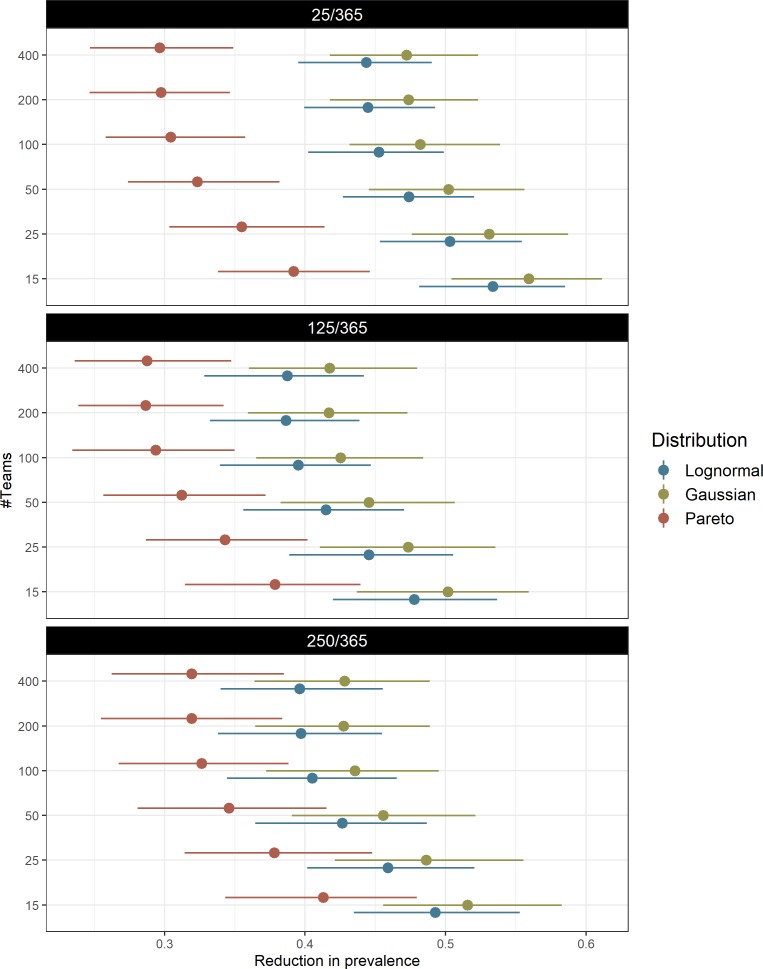
Interplay between logistics and human population topologies.Model predicted interaction of logistical MDA considerations (speed of coverage – teams) with different population mobility levels (given in black background over each panel) in determining intervention impact for the explored transmission heterogeneity distributions. Points and adjacent lines indicate the median and interquartile ranges (based on 100 simulations for each parameter set).